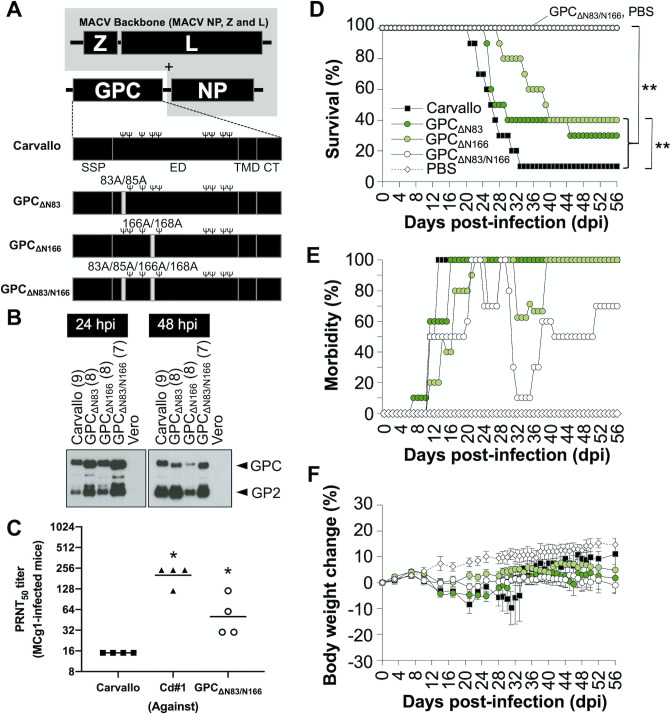
Carvallo strains without the N-glycans on GPC.(A) Schematic representation of the genome of MACVs. Ψ in black character represents an N-glycosylation site. (B) The representative WB for GPC. (C) Susceptibility of MACV GPCΔN83/N166 to mouse antiserum to Cd#1. To determine the susceptibility of Carvallo, Cd#1 and MACV GPCΔN83/N166 to the antiserum, the PRNT50 was determined by neutralizing assay. Statistically significant differences compared with Carvallo are indicated by asterisks (*, P<0.05 by Mann-Whitney U test). (D) Survival rate of the IFN-αβ/γ R-/- mice after infections (Carvallo N = 10, MACV GPCΔN83 N = 10, MACV GPCΔN166 N = 10, MACV GPCΔN83/N166 N = 10, PBS N = 6). Statistically significant differences are indicated by asterisks (**, P<0.01 by log rank test). (E) Morbidity rate of the IFN-αβ/γ R-/- mice after infections. (F) Body weight changes were monitored on the indicated days. Error bars indicate the SEM. The data shown are pooled from two independent experiments. The data of Carvallo- and PBS-inoculated mice in Fig 5D to 5F were overlapped with the data in Fig 1D–1F since these infectious experiments were performed together at the same time.